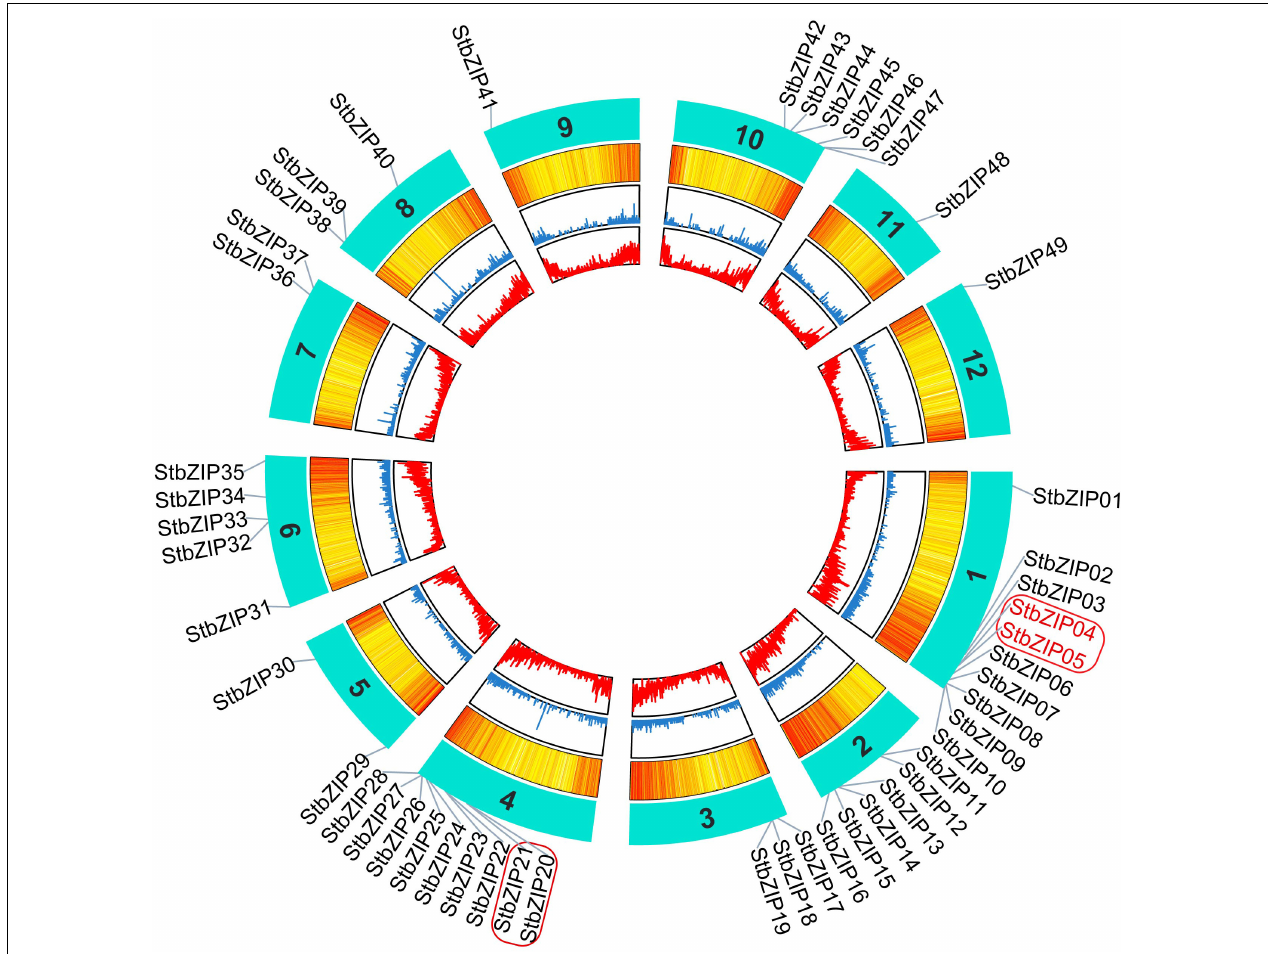
FIGURE 3 | Distribution of StbZIP genes on potato chromosomes. In potato, 49 StbZIP genes were successfully mapped to 12 potato chromosomes. The red box indicate the gene cluster, while the tandem duplication pair is featured by the red